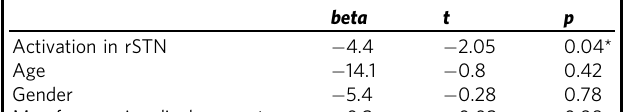
Table 2 Linear regression shows that NMI predicts